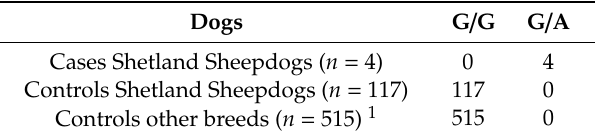
Table 4. Association of the genotypes at PCK2 :c.1658G > A with paroxysmal dyskinesia. Dogs G / G G / A Cases Shetland Sheepdogs ( n =